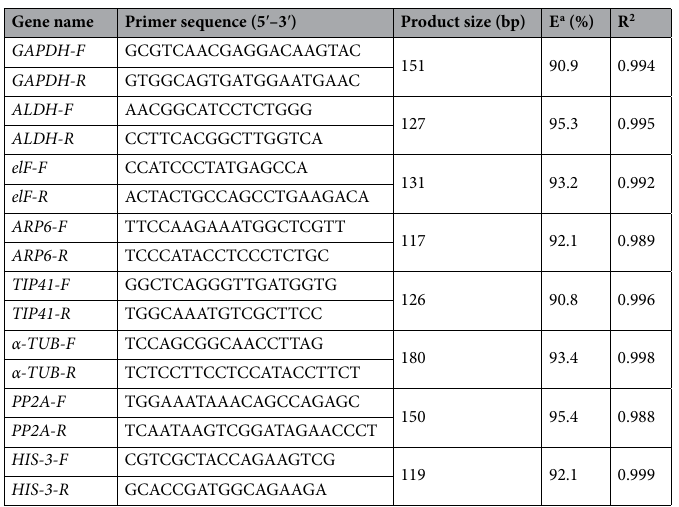
Table 1. Details of primers and amplification characteristics for RT-qPCR of the eight candidate reference genes. a The amplification efficiency of RT-qPCR.